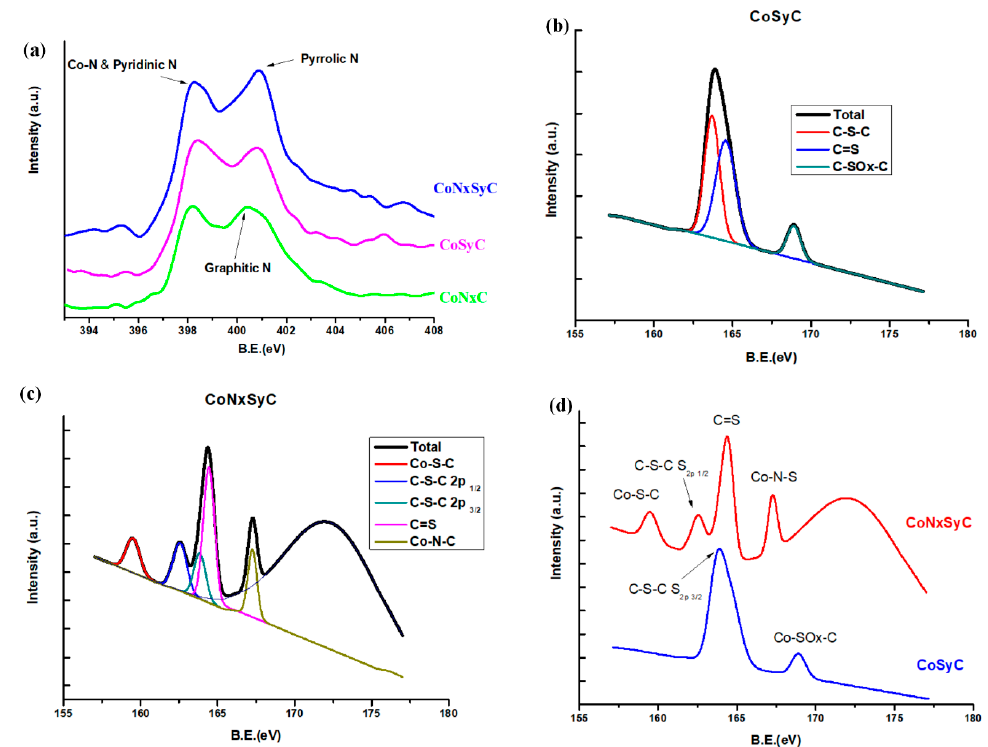
Figure 2. X-ray photoelectron spectroscopy (XPS) spectra of ( a ) N1s of all co-catalysts ( b ) S2p of CoSyC ( c ) S 2p of CoNxSyC ( d ) Comparing S 2p of CoSyC with CoNxSyC.